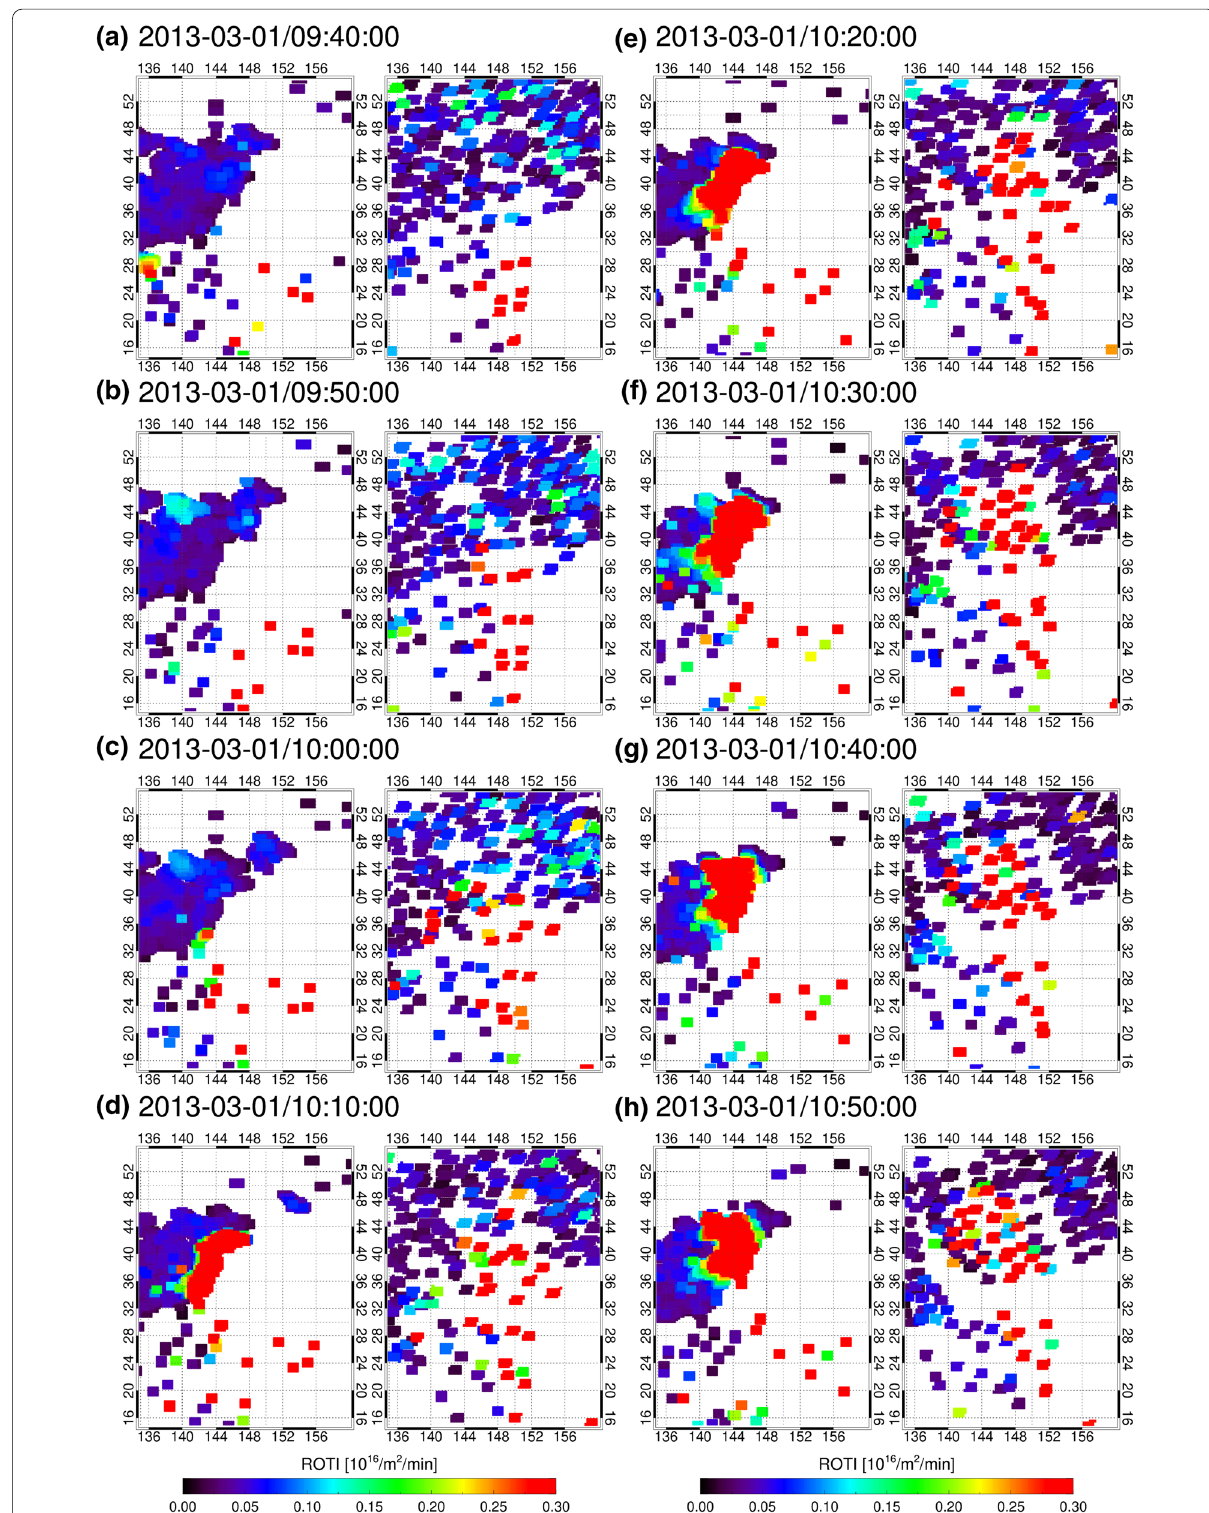
Fig. 4 Two-dimensional maps of ROTI near Japan and Australia showing 10-min intervals from 09:40 to 10:50 UT on March 1, 2013. In each panel, ROTI values over Japan are shown on the left while those over Australia mapped onto the northern hemisphere along the magnetic field lines using the IGRF-13 model are shown on the right. The color code indicates the ROTI value within a range of 0.0 to 0.3